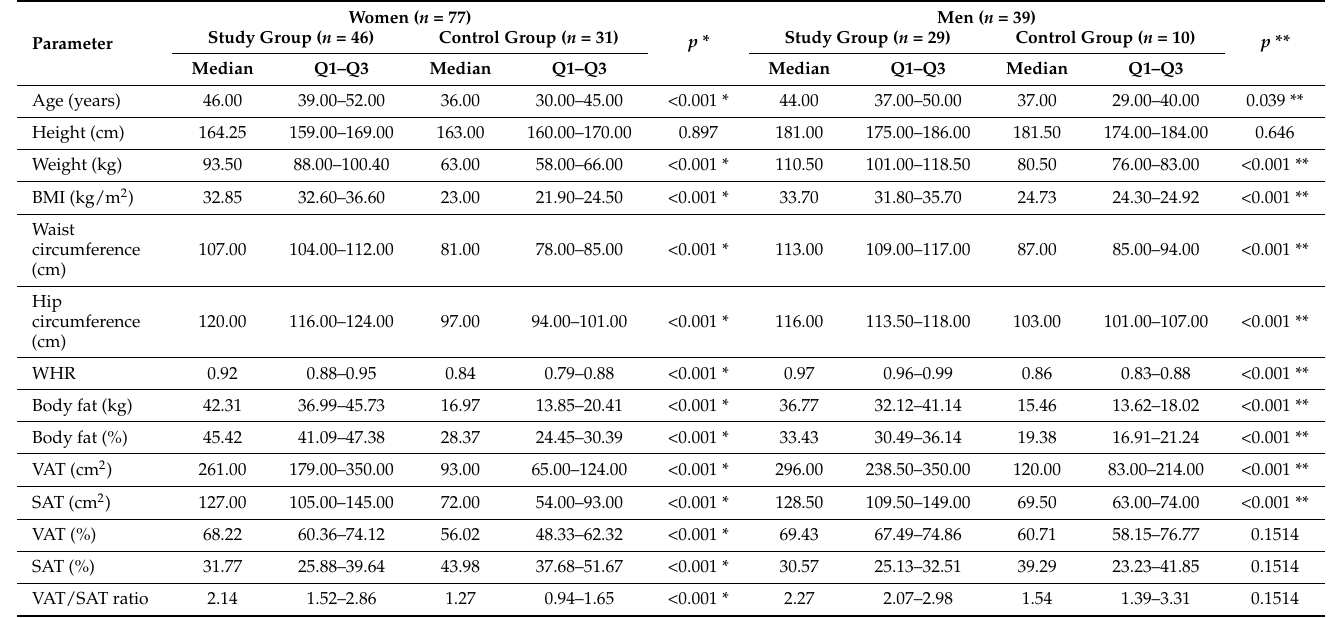
Table 1. Comparison of anthropometric and body composition parameters of women and men from the study and control groups.